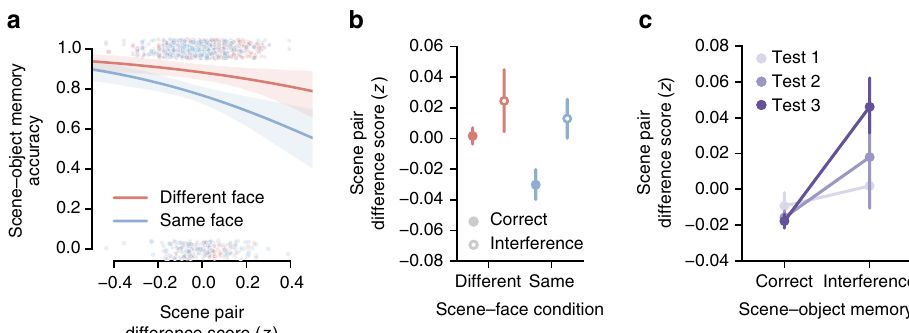
Figure 3 | Learning-driven decreases in representational overlap prevent interference during future learning. ( a ) In a logistic regression analysis, lower hippocampal scene pair differences scores (lower representational overlap) in the Same Face and Different Face conditions predicted resistance to interference during scene-object learning ( w 2 4 : 71, P ¼ 0.030). Each point represents an individual scene pair difference score from scene-preferring 1 ¼ hippocampal voxels pooled across subjects. Lines and shading indicate logistic regression fits and standard errors for each condition. ( b ) As an alternative visualization of a , mean scene pair difference scores are shown as a function of scene-face condition (Same Face, Different Face) and subsequent scene- object memory (correct versus interference). Data are averaged across scene–object test repetition. ( c ) Scene pair difference score interacted with test 5 : 96, P ¼ 0.015): scene-object interference errors in later test repetitions were associated repetition in predicting subsequent scene-object memory ( w 2 1 ¼ with larger scene pair difference scores than errors in early test repetitions. Scene pair differences scores are averaged across the Same Face and Different Face conditions for each test repetition. For b and , c plotted data represent mean ± s.e.m. across subjects. See also Supplementary Figs 4 and